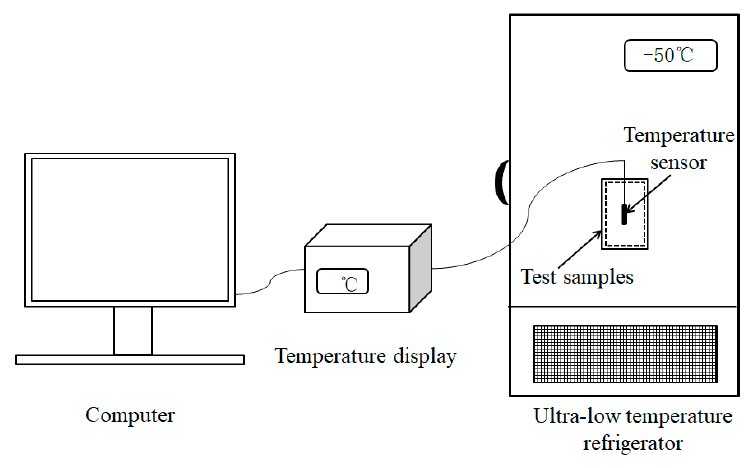
Figure 2. Low-temperature resistance test equipment.